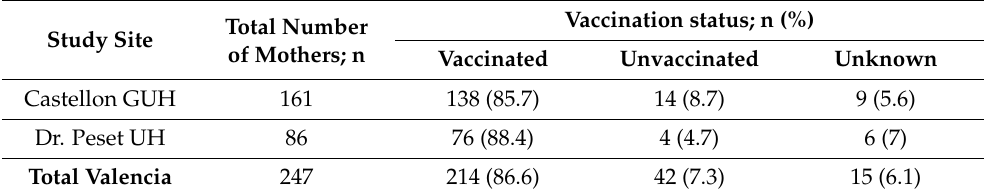
Table 4. Description of the maternal immunization status of all recruited cases in the Valencia Region.